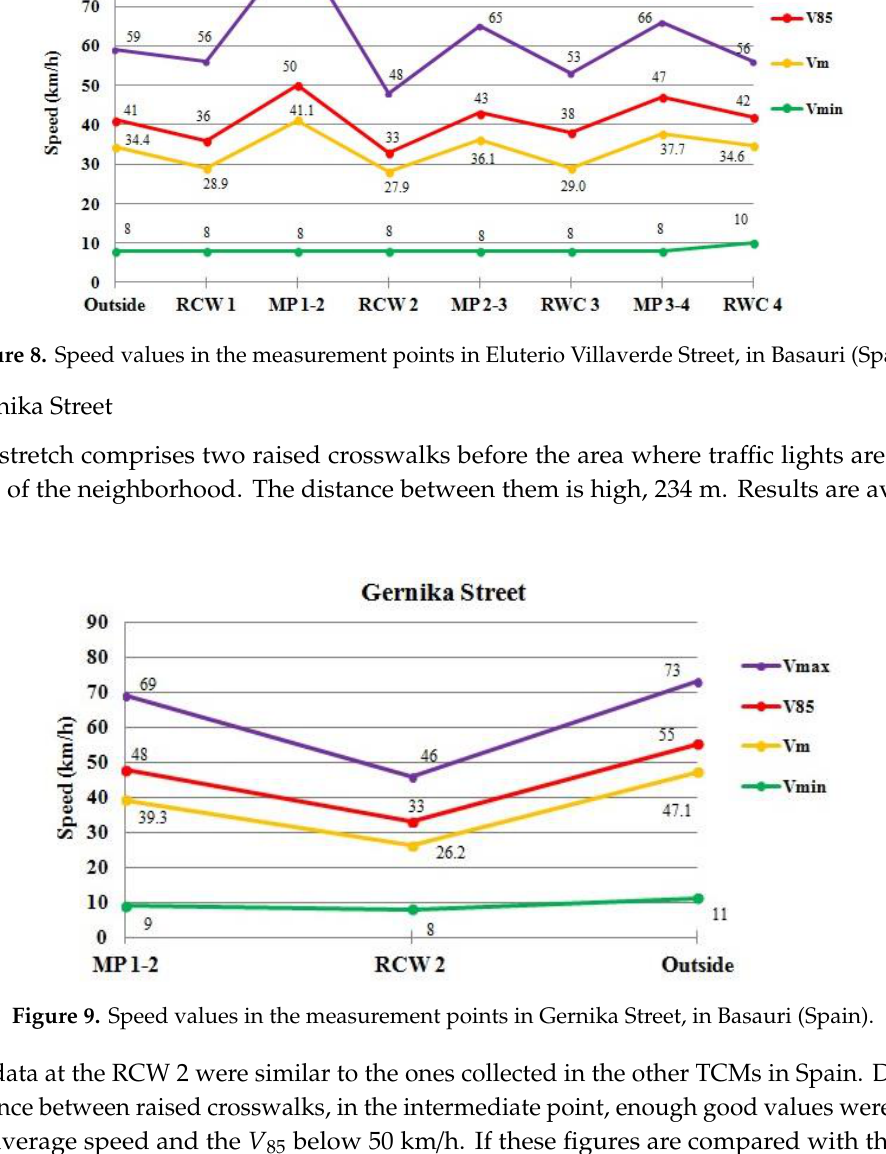
Table 2. Summary of obtained speed values at the traffic calming measures.